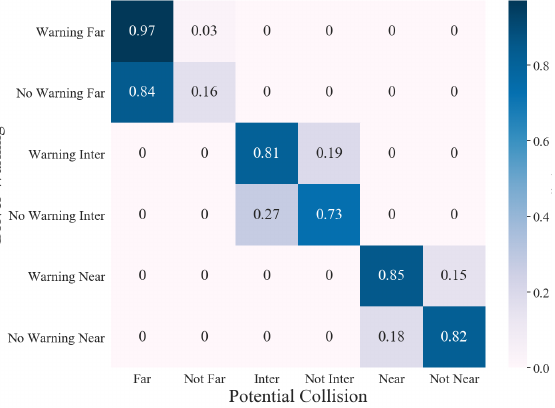
Figure 19. Confusion matrix of three detection regions and their binary